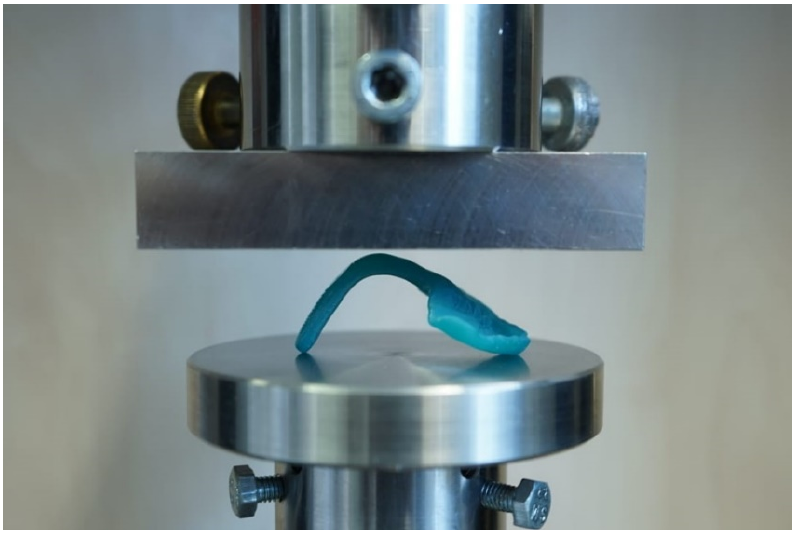
Figure 8. Test setup for TPP test with inserted test specimen in the universal testing machine.